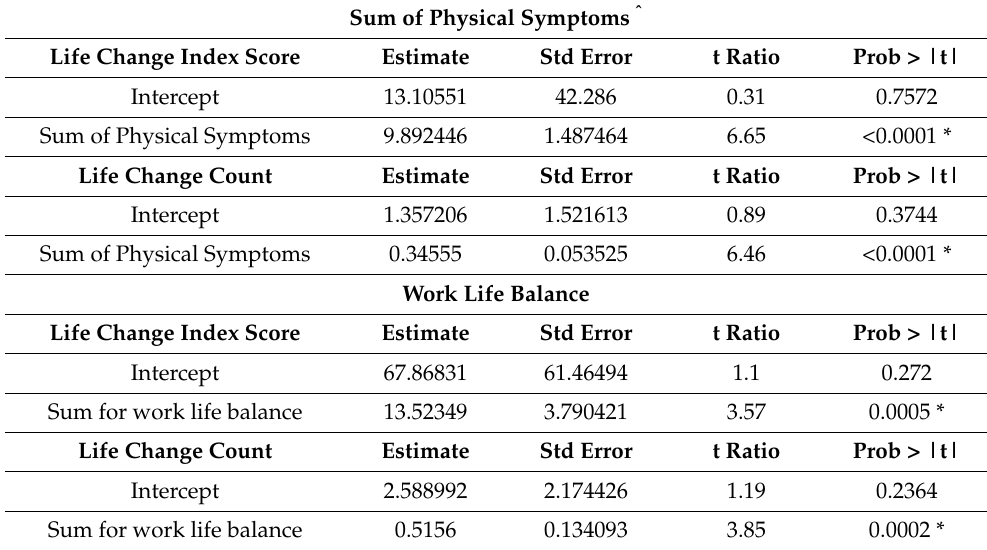
Table 5. Linear regression results for life change index count and sum of physical symptoms with sum of physical symptoms and work life